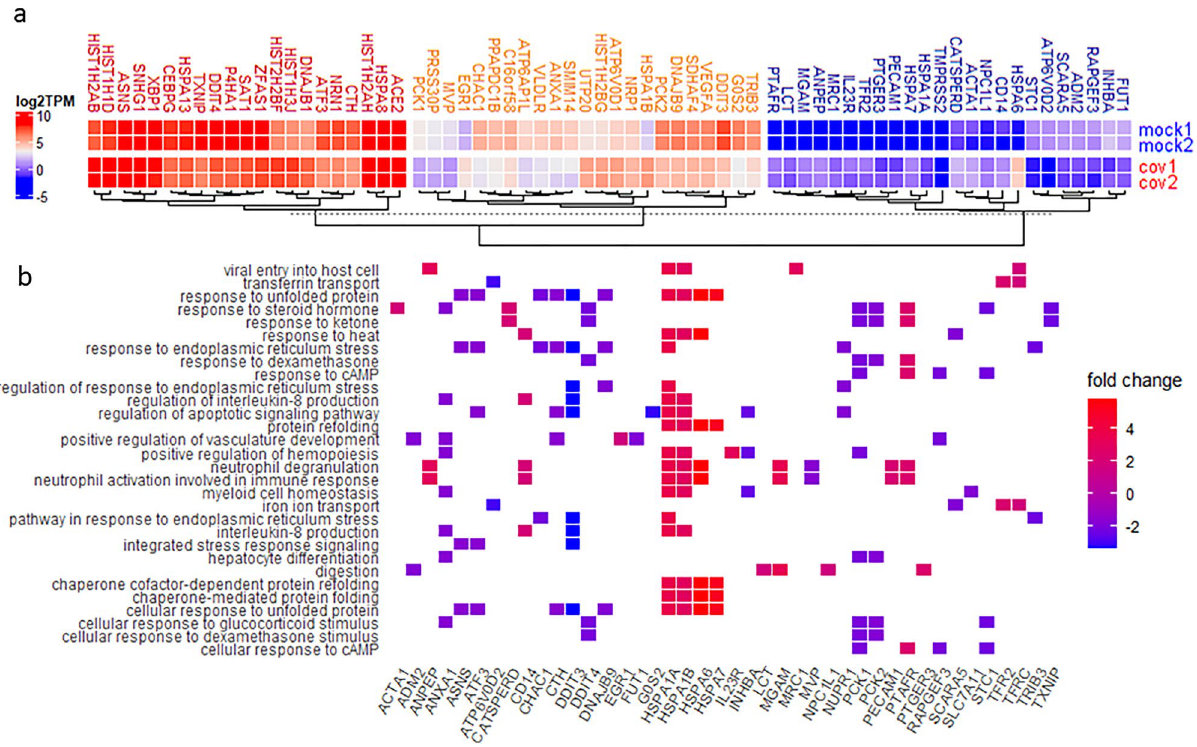
Figure 3. DEGs of SARS-CoV-2 infection of HEK293T-hACE2 cells. ( a ) Heatmap of DEGs in mock or SARS- CoV-2 infected HEK293T-hACE2 cells. Mock1 and mock2 indicate two replicates of mock infection and cov1 and cov2 indicate two replicates of SARS-CoV-2 infections. ( b ) Heatmap view of GO-BP enriched by DEGs from mock or SARS-CoV-2 infected HEK293T-hACE2 cells.